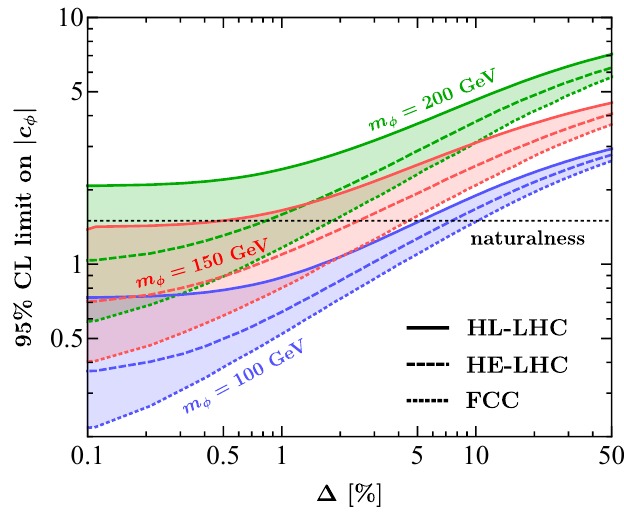
Figure 8 . 95% CL limits on | c φ | derived from the binned-likelihood analysis of the D S spectra as a function of the assumed systematic uncertainty ∆ . The bounds for the HL-LHC (solid lines), the HE-LHC (dashed lines) and the FCC (dotted lines) are displayed for the three benchmark values m φ = 100 GeV (blue), m φ = 150 GeV (red) and m φ = 200 GeV (green) of the scalar mass. The √ dotted black line corresponds to the condition | c φ | = 3 y 2 = 1 . 5 that derives from naturalness t arguments in models of neutral naturalness. See main text for additional